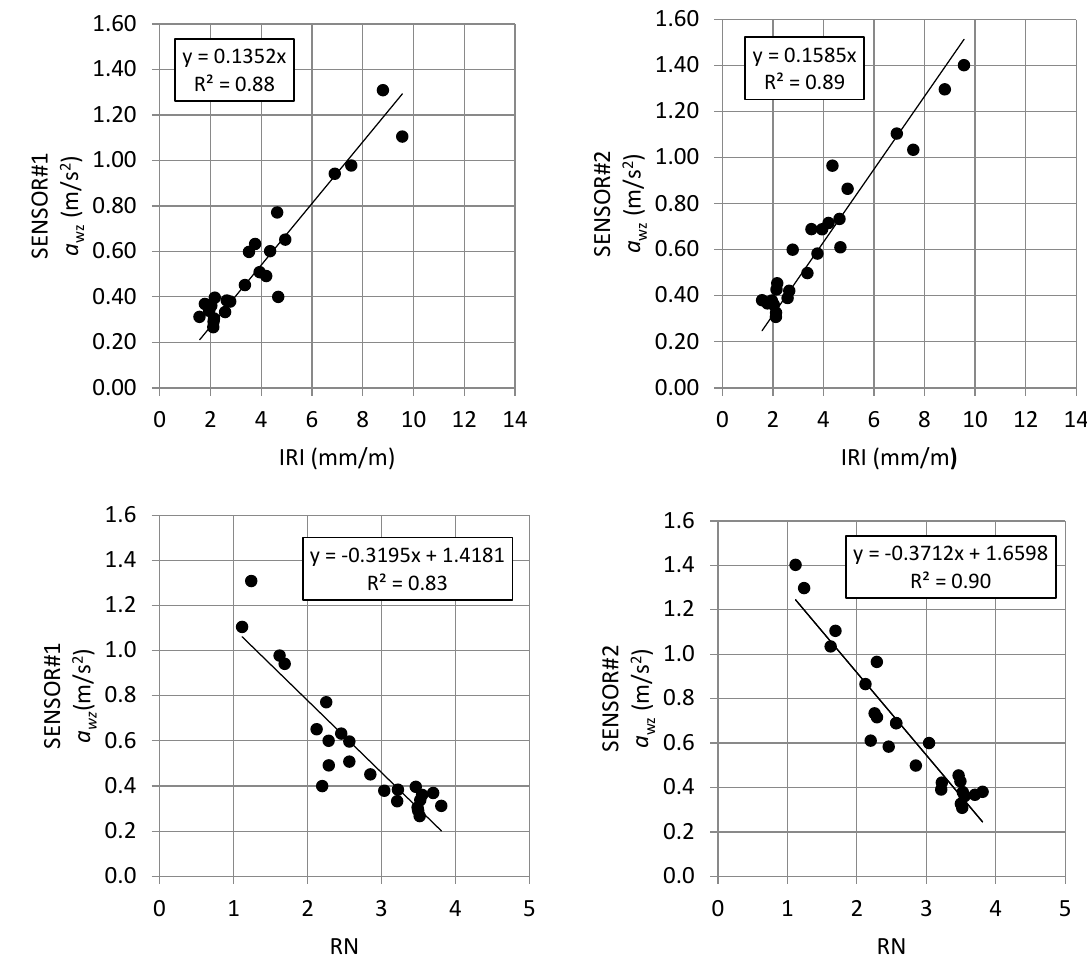
Figure 15. Linear regression a wz –IRI vs. a wz –RN.